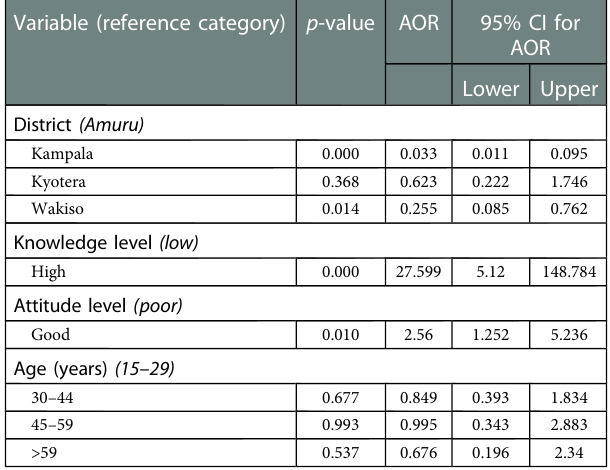
TABLE 8 Adherence to the recommended guidelines for the prevention and control of COVID-19. Variable